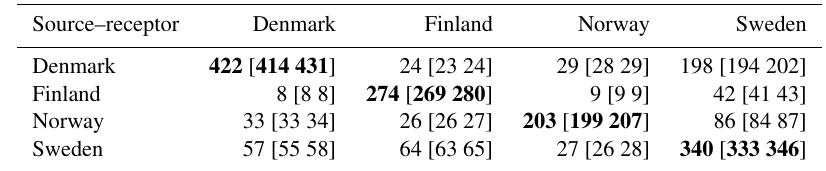
Table 6. Source–receptor relationships of the contributions of anthropogenic emissions from the Nordic countries to the premature mortality in the Nordic area. The brackets show the 95% confidence